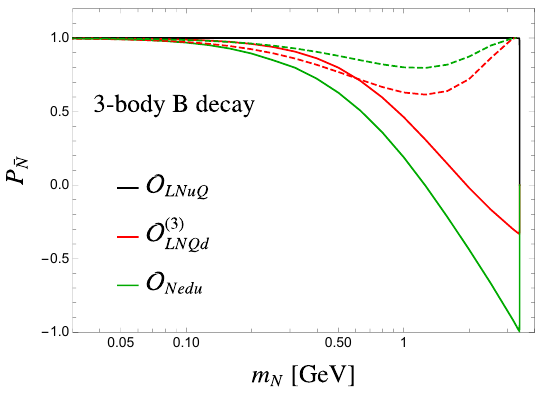
Figure 2 . Fractional polarization of ¯ N as a function of heavy neutrino mass m N . The black (red) [green] line corresponds to the case with ¯ N produced from a scalar ( O LNuQ ), tensor ( O (3) vector ( O Nedu ) operator. The solid (dashed) lines are for ¯ B 0 → D + ( D ∗ + ) e − ¯ N .